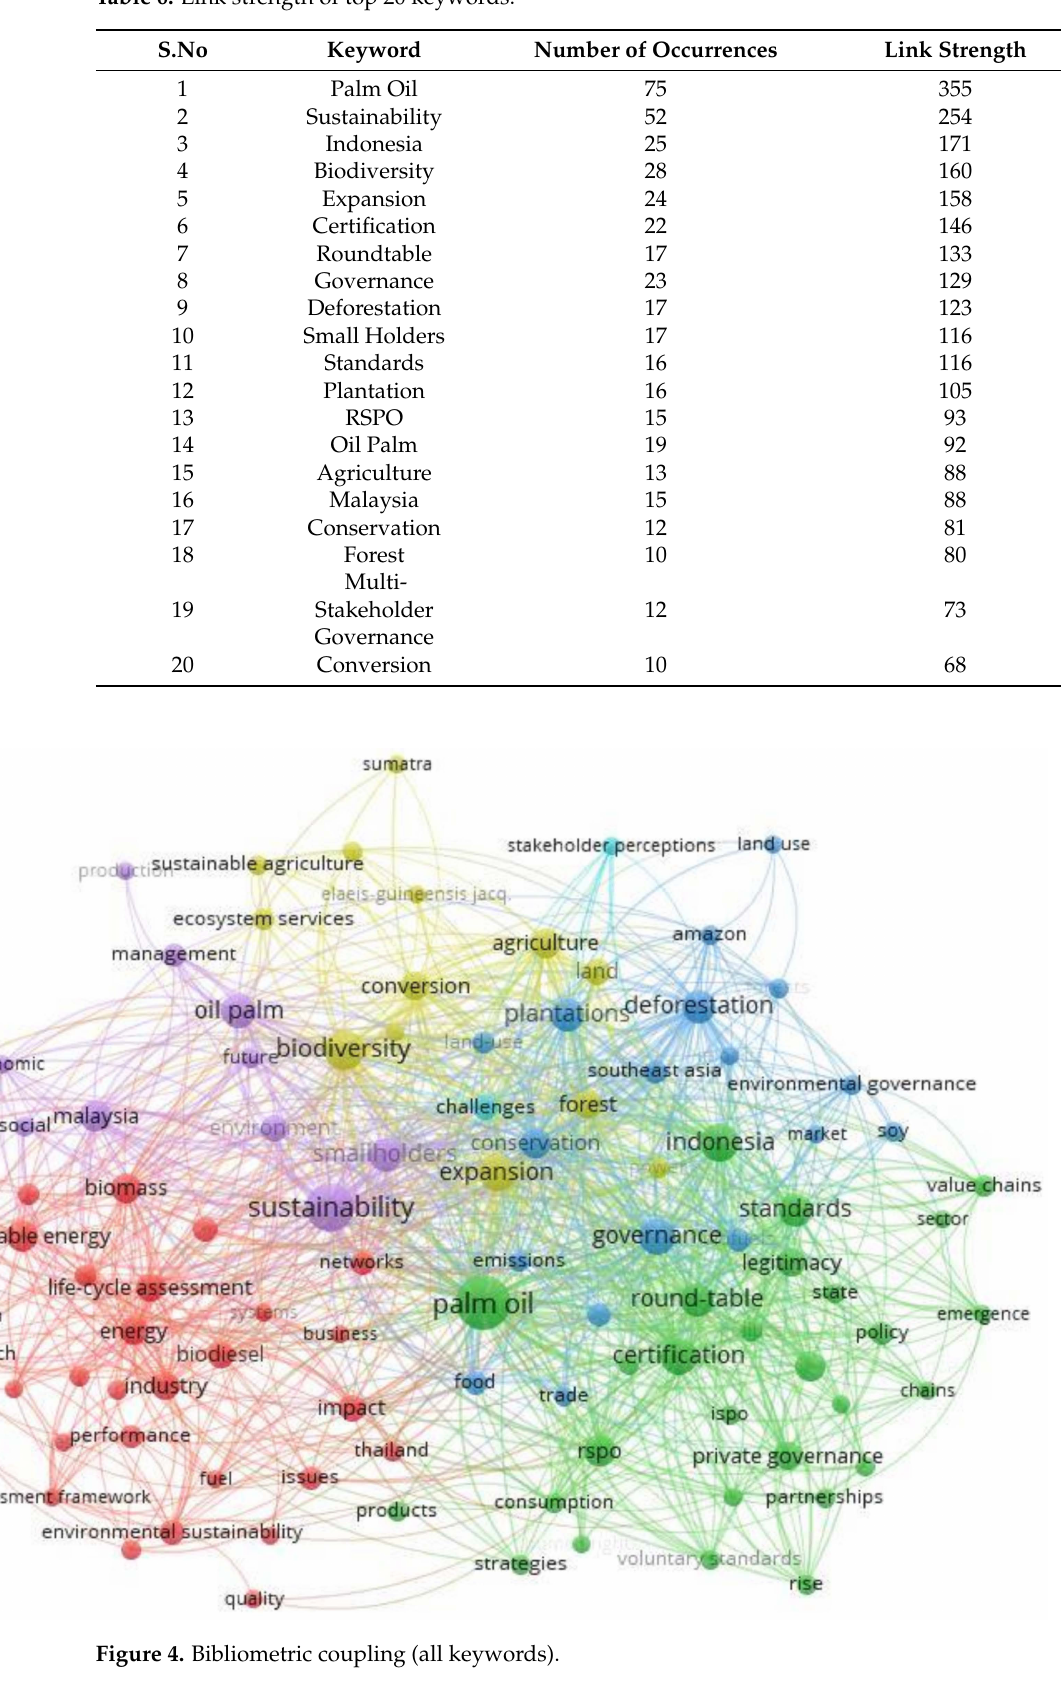
Table 6. Link strength of top 20 keywords.